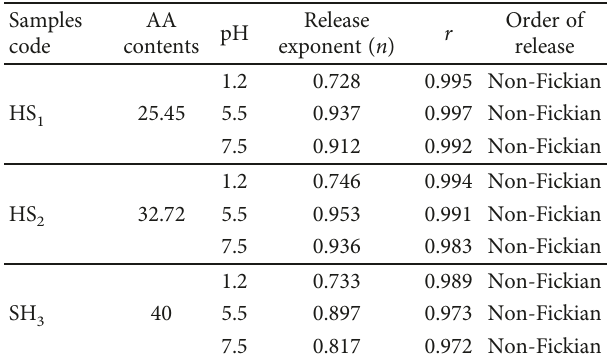
Table 7: E ff ect of di ff erent contents of AA on the drug release mechanism of Poly (CMCS- g -AA) hydrogels in solutions of di ff erent pH values using EGDMA as crosslinking agent (0.7% of AA).